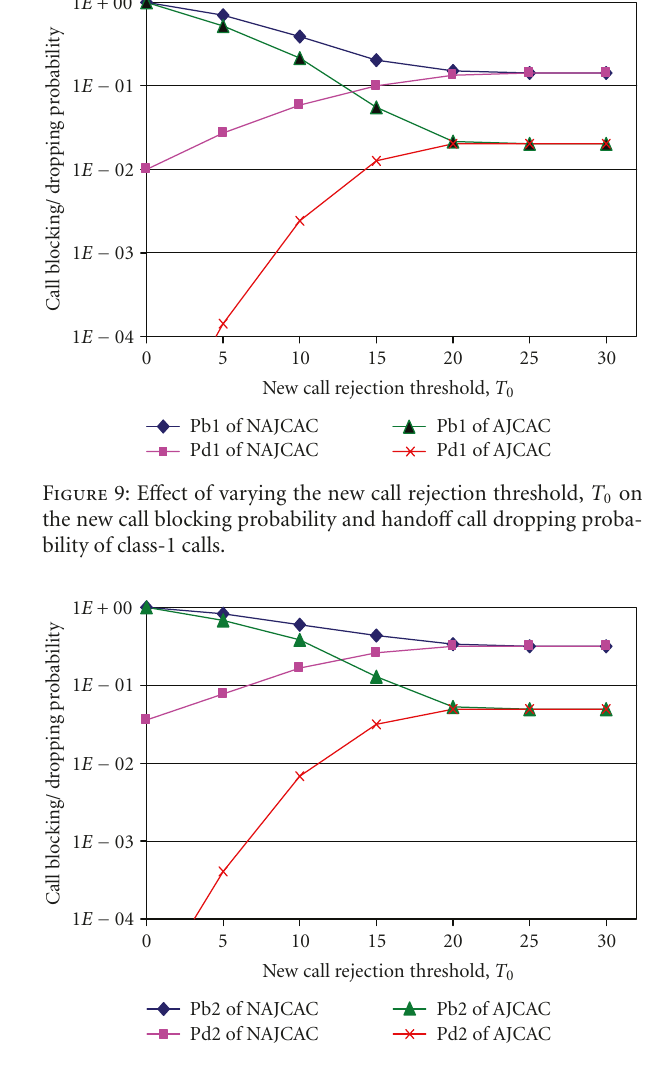
Figure 8: E ff ect of varying the call arrival rate on the new call blocking probability and hando ff call dropping probability of class- 2 calls.